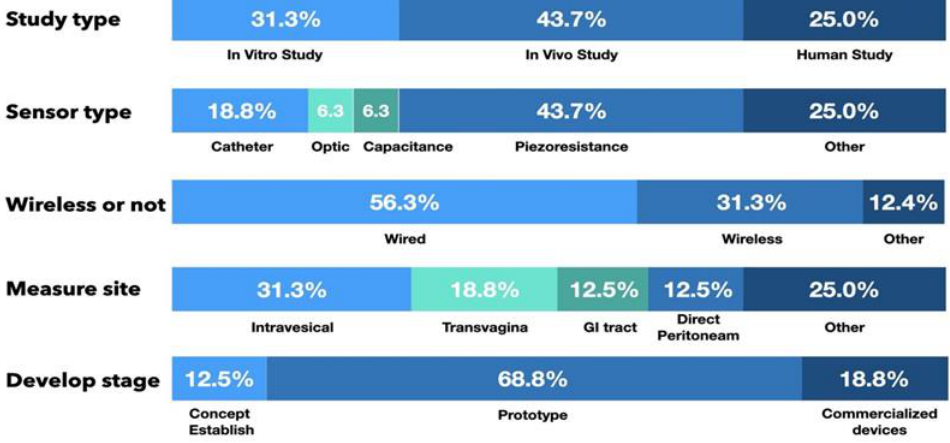
Figure 5. The characteristic of the included studies.